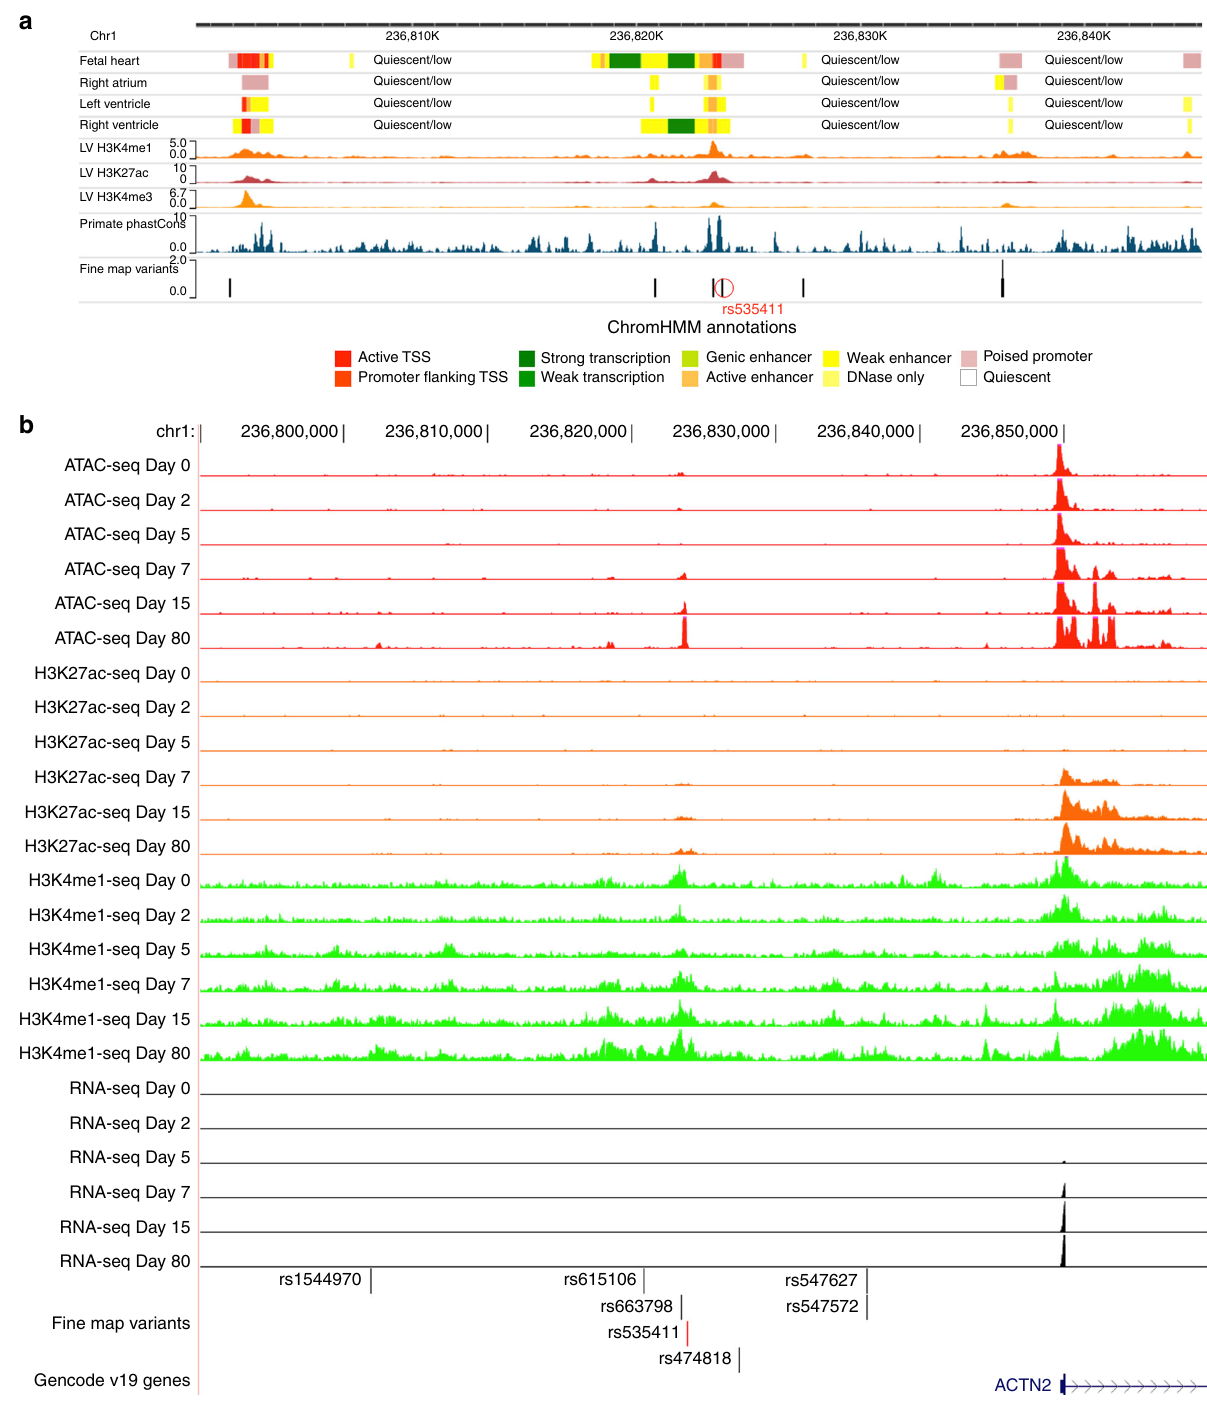
Fig. 3 Fine-mapping of the ACTN2 locus. a A zoomed in view of the credible set region for the ACTN2 locus in Roadmap Epigenomics. b ATAC-seq, ChIP- seq (H3K27ac, H3K4me1), and RNA-seq peaks in the hESC-to-cardiomyocyte differentiation model for the fi ne-mapped SNPs that overlap cardiac-speci fi c active chromatin states. We see that one SNP (rs535411) is overlapping an ATAC-seq peak that starts to develop on Day 7 of cardiomyocyte differentiation and remains active until Day 80. Ranges for peak values: ATAC-seq: 0 – 127, H3K27ac-seq: 0 – 127, H3K4me1-seq:0 – 10. b was created using the UCSC genome browser p -value < 5e-7 from the credible set. Then, we intersected that set of SNPs with active chromatin states using the Roadmap Epigenomics ChromHMM 25-state model 13 for cardiac tissues and with candidate cis-regulatory elements (ccREs) from the ENCODE registry 14 . Of 111 strongly associated variants in almost perfect LD within the credible set for ACTN2 , only seven